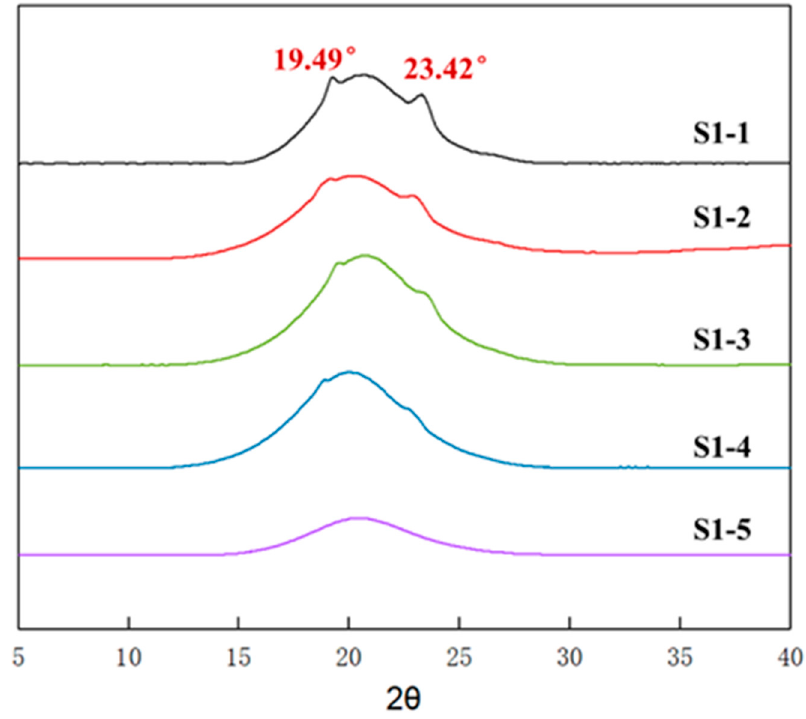
Figure 4. WAXD spectra of elastomers with different R